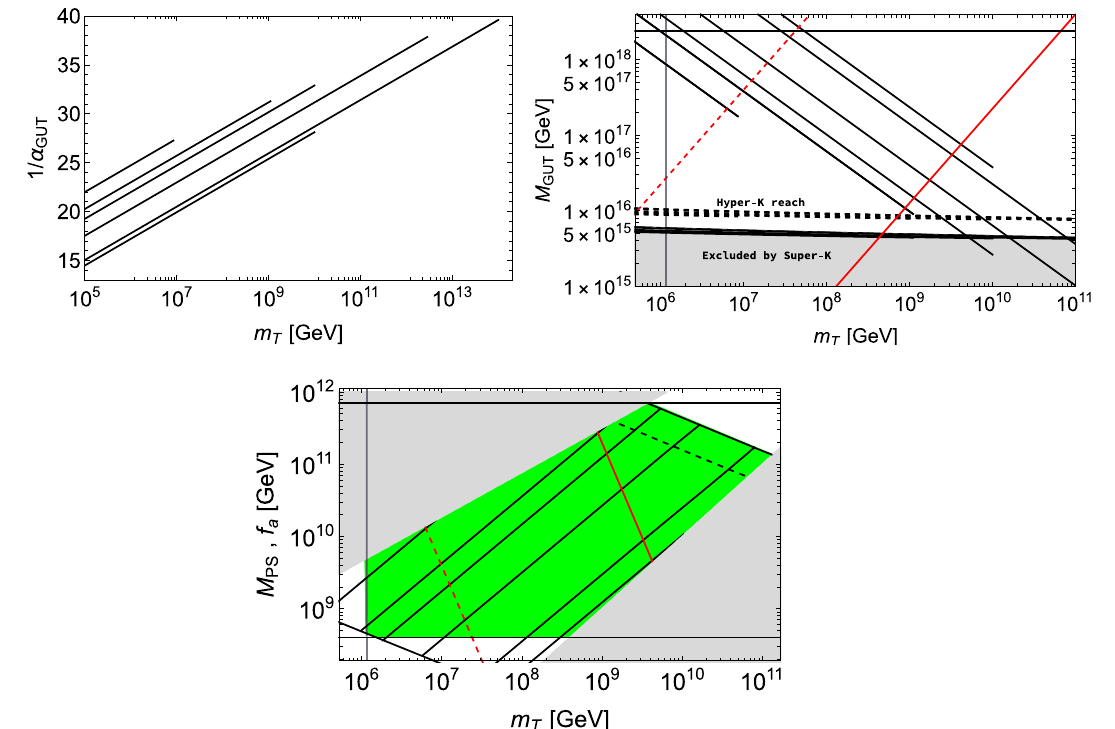
Fig. 2 Plots for M PS = f a and fixed m D = 2 TeV. The top-left (right) panel shows 1 /α GUT ( M GUT ) as a function of m T , where the solid black diagonal lines from left-to-right (right-to-left) correspond to m 45 , 126 / m T = 2000 , 300 , 100 , 15 , 1, and 1 / 3, respectively. In the top-right panel, the top horizontal line corresponds to M GUT = M P . The gray shaded region is excluded by the lower bound on proton life- time from the Super-K experiment, and the reach of the future Hyper-K experimentisdepictedbyoverlappinghorizontaldashedlines.Thesolid blackverticallinedepictsthelowerboundon m T for m HC = 2 . 7 × 10 12 GeV. The dashed (solid) red diagonal line depicts the lower-bound on m T for m HC = 10 − 4 M GUT ( M GUT ) . The bottom panel shows